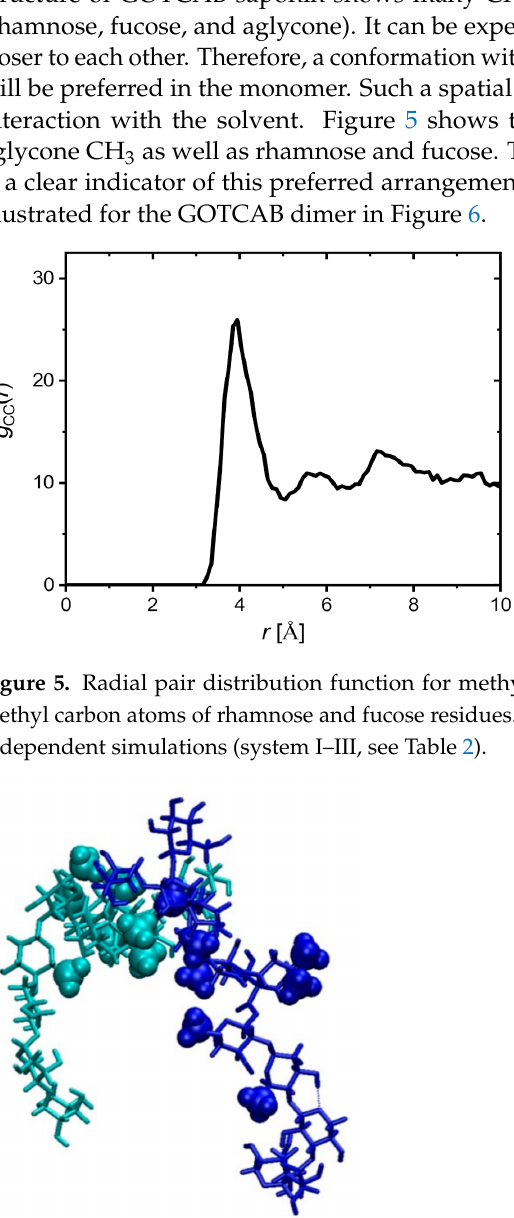
Table 3. Average number of clusters of GOTCAB molecules, (cid:104) N ( GOT ) run trajectories.